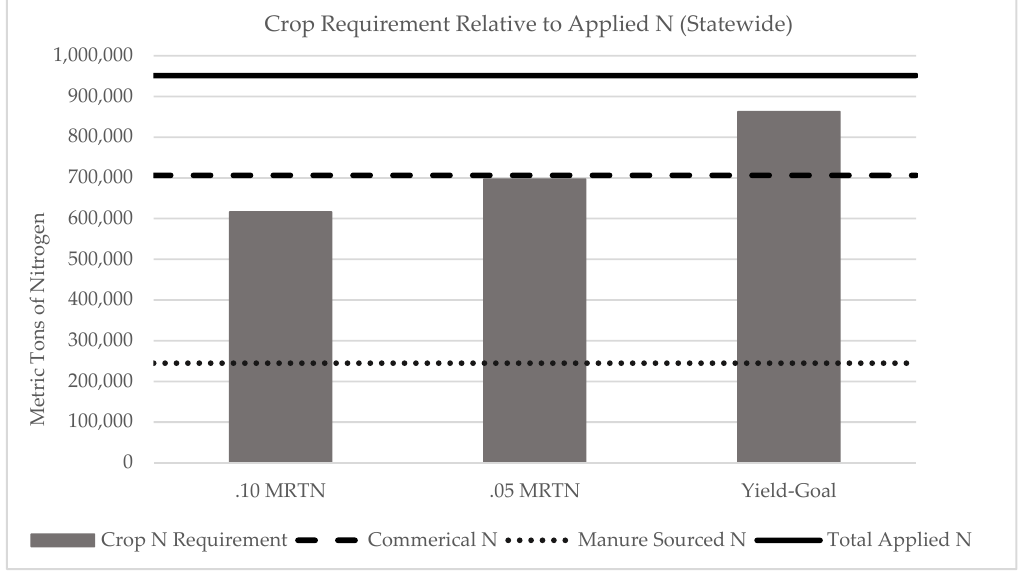
Figure 1. Statewide Crop Requirement Relative to Total Applied N.